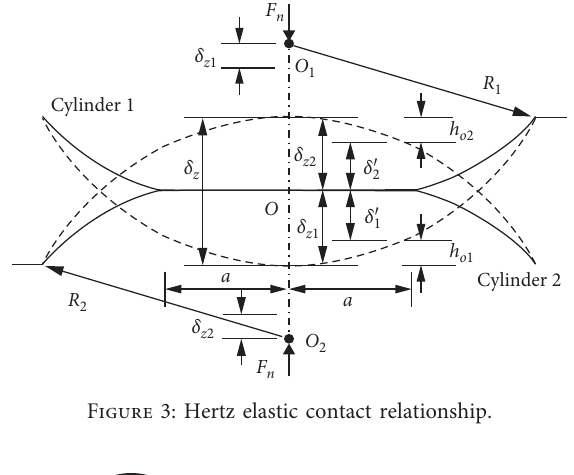
Figure 3: Hertz elastic contact relationship.